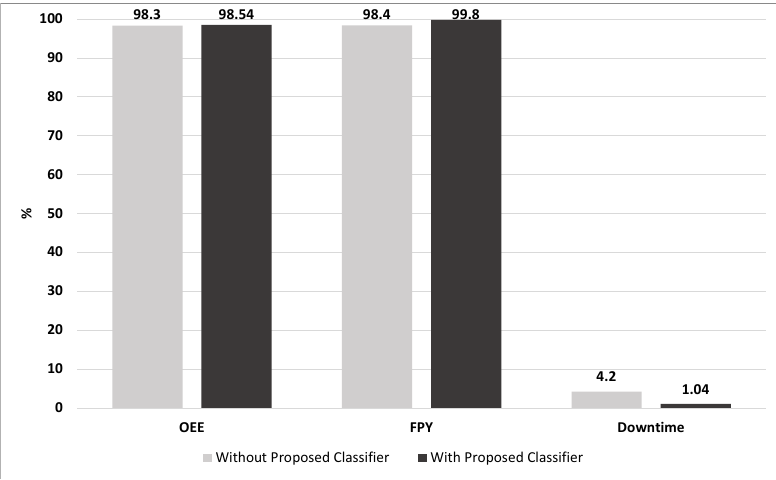
Figure 10. Nissei ASB machine indicators with and without the proposed